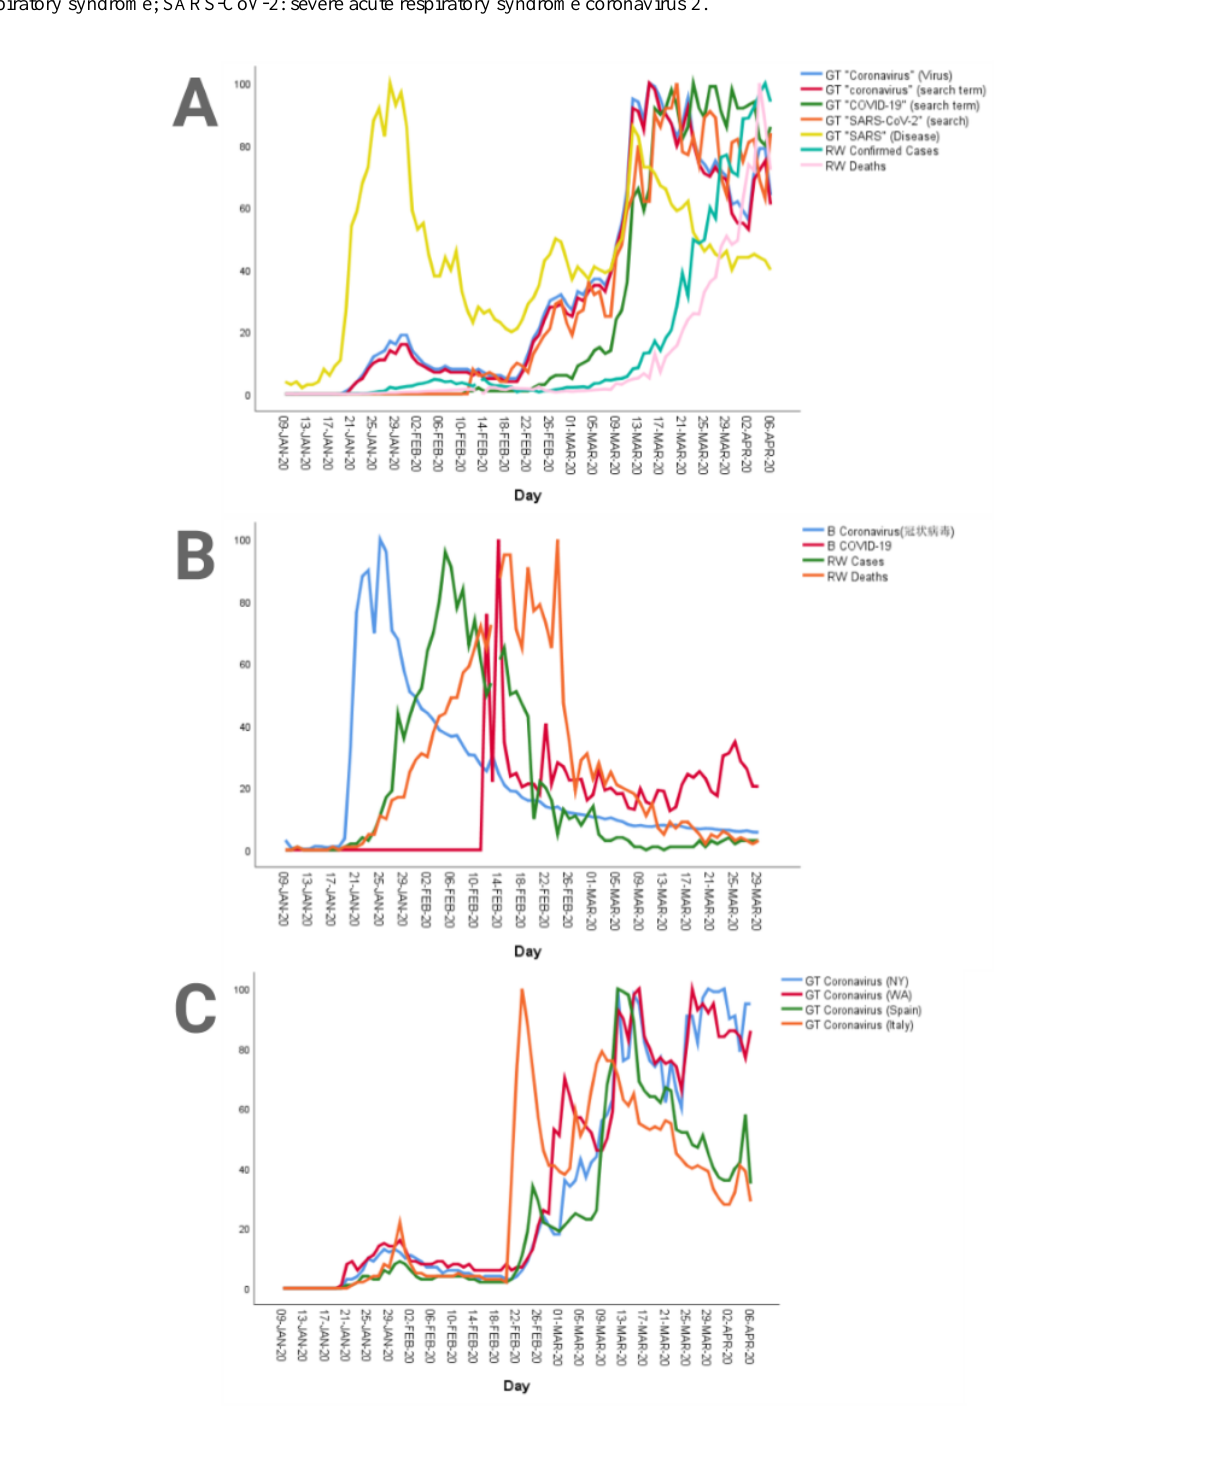
Figure 5. Normalized Google Trends and Baidu Index search terms by date compared to real-world new confirmed cases and deaths from COVID-19: (A) RW worldwide data and GT COVID-19 search terms, (B) China RW data and Baidu Index COVID-19 search terms, and (C) GT search for coronavirus (virus) by geographic region. B: Baidu Index; COVID-19: coronavirus disease; GT: Google Trends; RW: real-world; SARS: severe acute respiratory syndrome; SARS-CoV-2: severe acute respiratory syndrome coronavirus